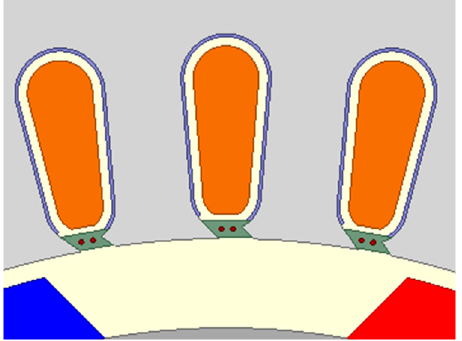
Figure 17. Fragment of a field model with an oblique slot opening.